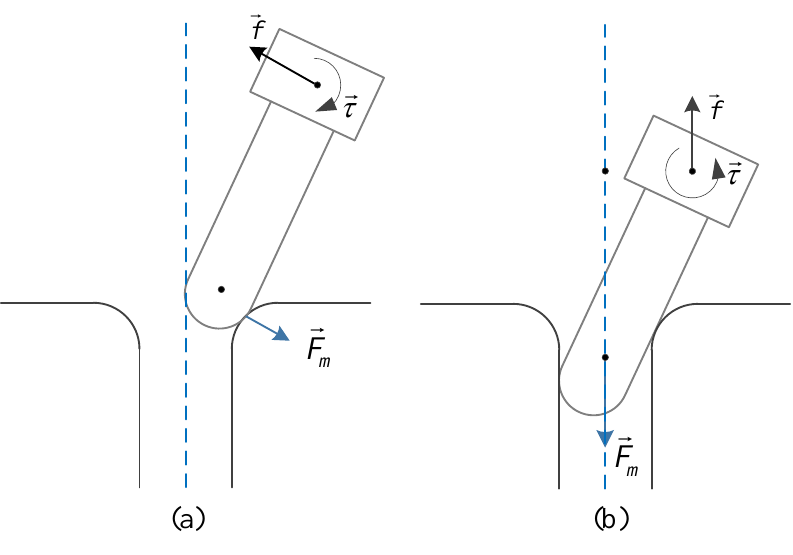
Figure 3. Peg-in-hole identified gestures: ( a ) surface contact gesture, the peg is touching the surface of the hole with lateral forces; and ( b ) lever effect gesture, the peg is already inserted in the hole without a correct orientation. Blue arrows represent the exerted